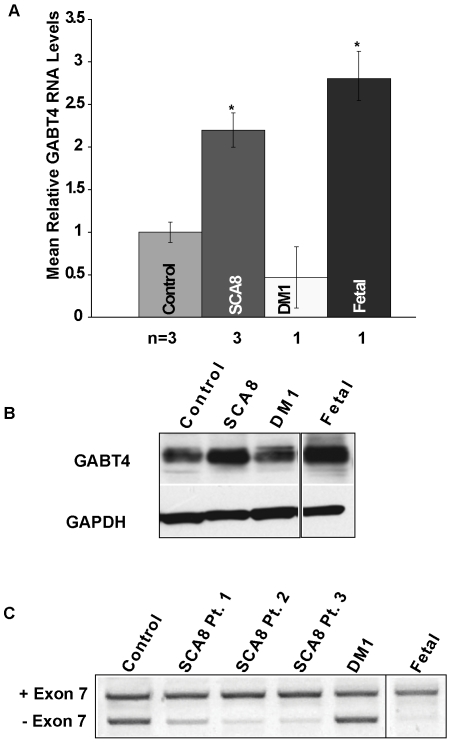
Upregulation and alternative splicing of GABT4 in human SCA8 brain.(A) qRT-PCR shows increased GABT4 RNA in frontal lobe autopsy tissue from adult SCA8 (n = 3) and control fetal (n = 1) tissue. * = significant difference (p<0.01). (B) Protein blot showing up-regulation of GABT4 in SCA8 and fetal frontal lobe vs. DM1 and Control with GAPDH as loading control. (C) RT-PCR of GABT4 shows a shift favoring exon 7 inclusion transcripts in SCA8 and control fetal frontal lobe tissue vs. adult control and DM1.